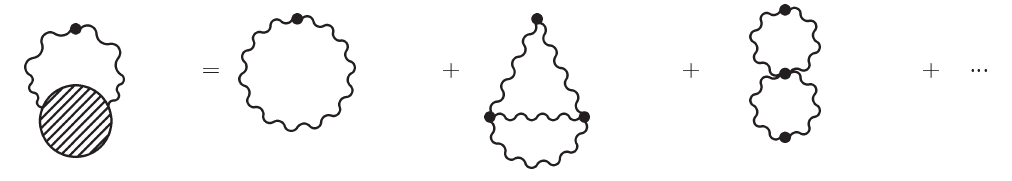
Figure 2 . Each of the N -point functions of (cid:12)gure 1 has a conventional diagrammatic expansion. This graph shows the lowest terms which contribute to the 2-point